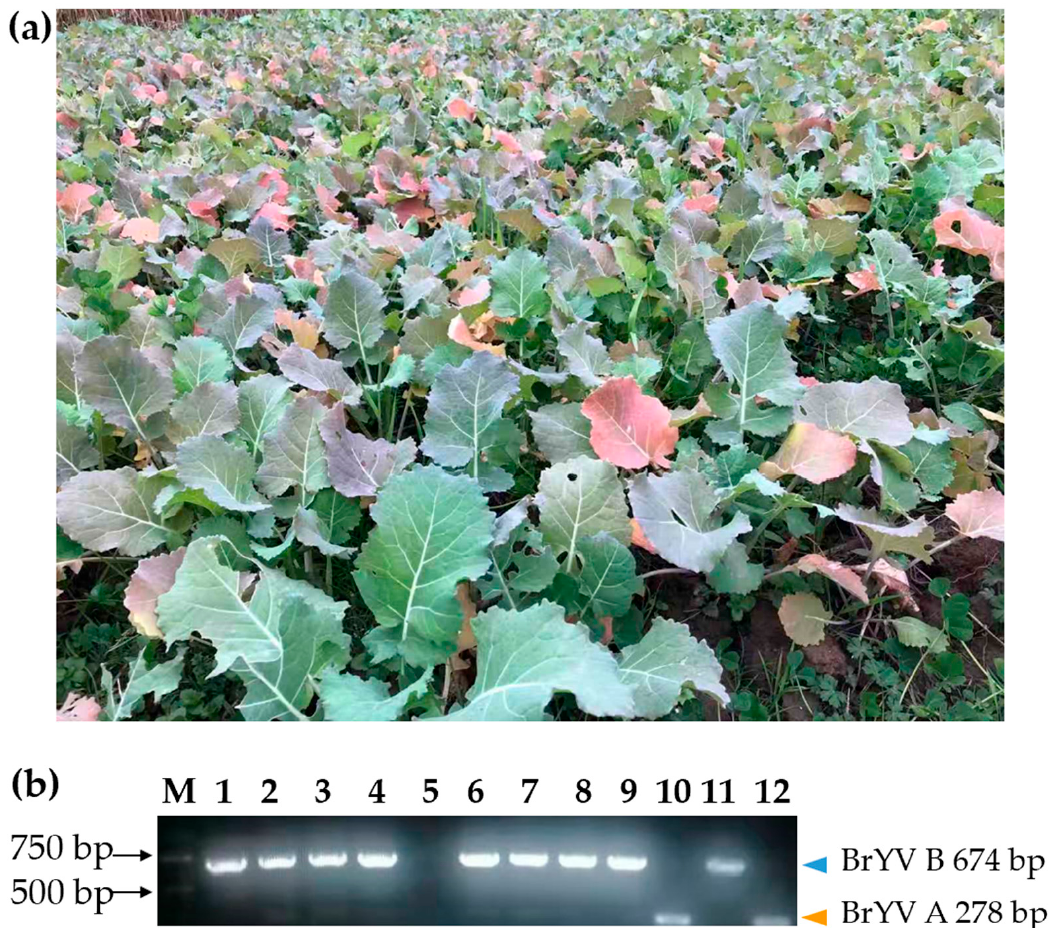
Figure 1. Symptoms of oilseed rape in the field and virus detection. ( a ) Oilseed rape showing the symptom of red leaves in Yangzhong in 2020. ( b ) RT-PCR based BrYV detection with primer pair BrYA484F/BrYB88F/BrYC257F/BrY761R, 278/674/505 bp. M stands for 100 bp DNA marker. Lanes 1 to 10 show 10 samples with red leaves collected in the field. The positive control of BrYV-B and BrYV-A plasmid in lane 11 and 12 was marked with an orange and blue triangle, respectively.